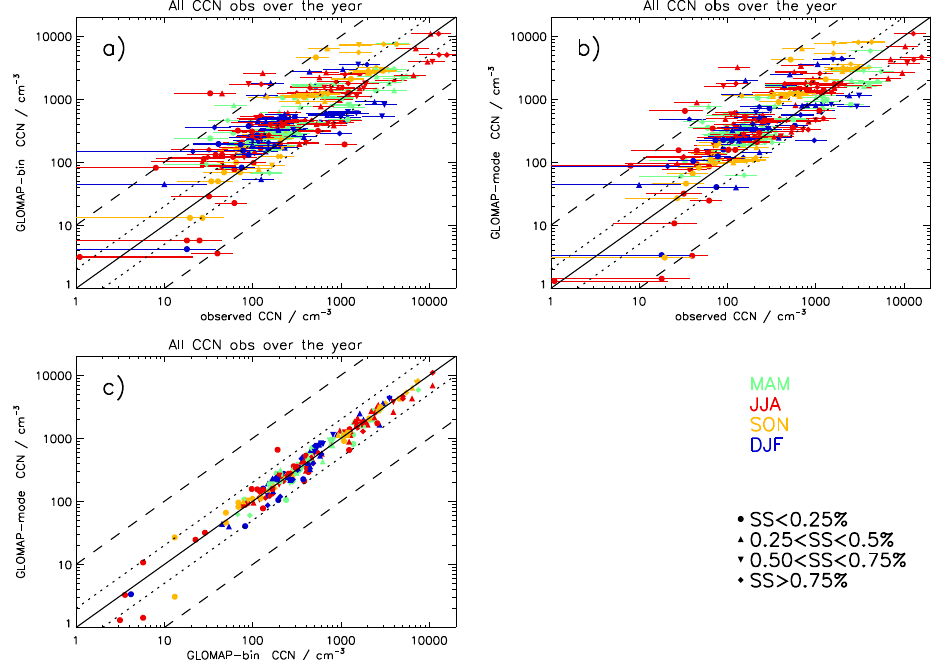
Fig. 16. Scatter plots showing comparison of simulated CCN concentrations against observations at the range of sites compiled in Spracklen et al. (2011) for (a) GLOMAP-mode (v6R), (b) GLOMAP-bin. A scatter plot of GLOMAP-bin against GLOMAP-mode simulated CCN is shown in panel (c) . Each model CCN is calculated based on the stated supersaturation for the corresponding measurement, following the method in Spracklen et al. (2011), using the monthly-mean for the month the observation was made.